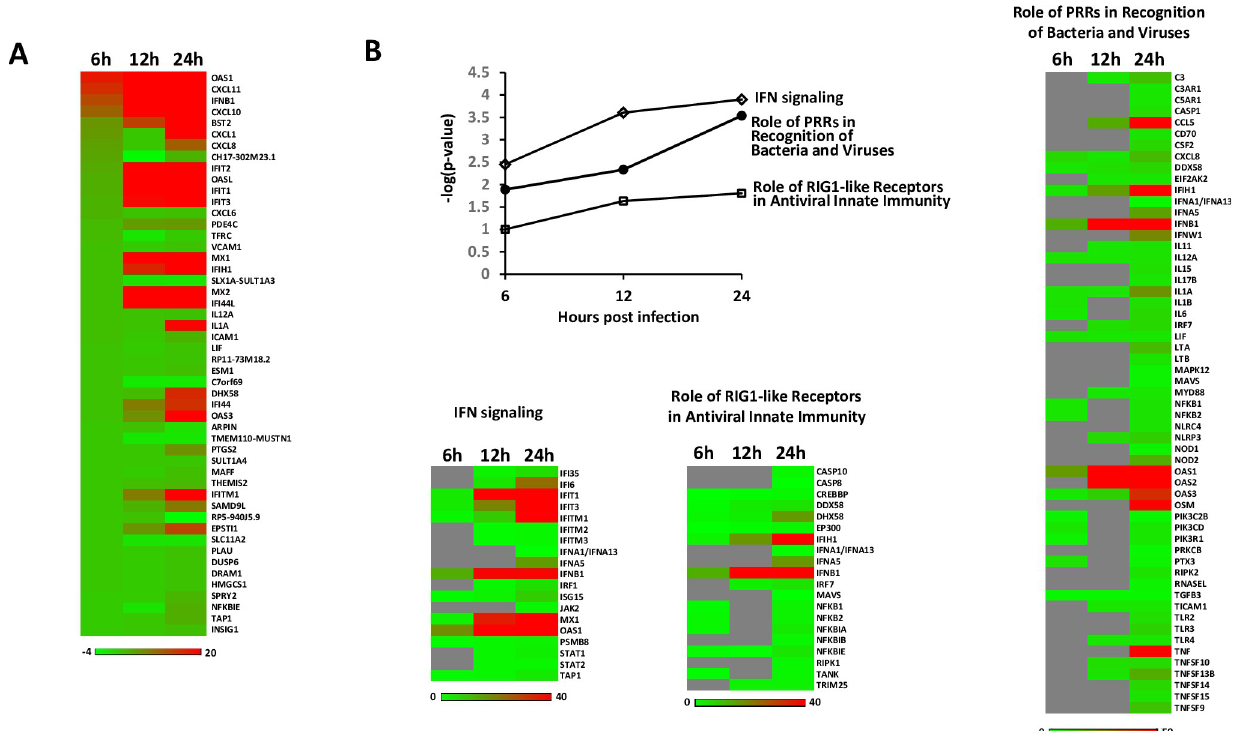
Fig 4. Gene expression analysis of fcMSCs infected with ZIKV for 6, 12, or 24 h. fcMSCs (n = 4) were infected with ZIKV for indicated times and RNA sequencing was performed as described in Materials and Methods. (A) Heatmap representation of the expression for top abundant transcripts; (B) Selected pathway activation at 6, 12, and 24 h post-infection is expressed as–log(-p-value) which takes into account both levels and numbers of differentially expressed genes that are assigned to the pathway. The differentially expressed genes belonging to the three selected antiviral pathways are represented in heatmaps. The expression intensities in all heatmaps is represented using green-red color scale with the scale bar at the bottom. Gray color indicates differentially regulated genes that did not reach statistical significance.